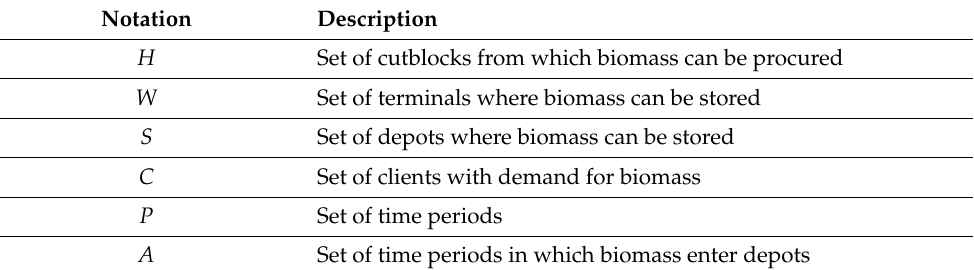
Table 1. Set notations used in the optimization model.